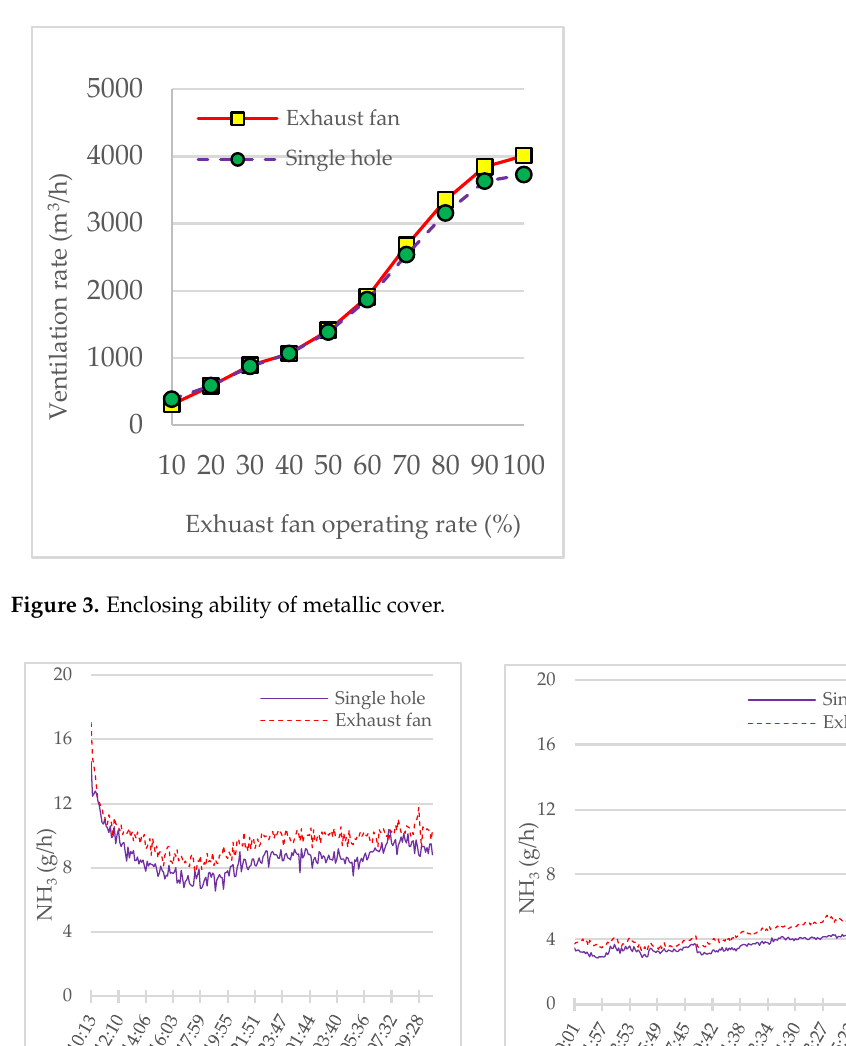
Figure 3. Enclosing ability of metallic cover.